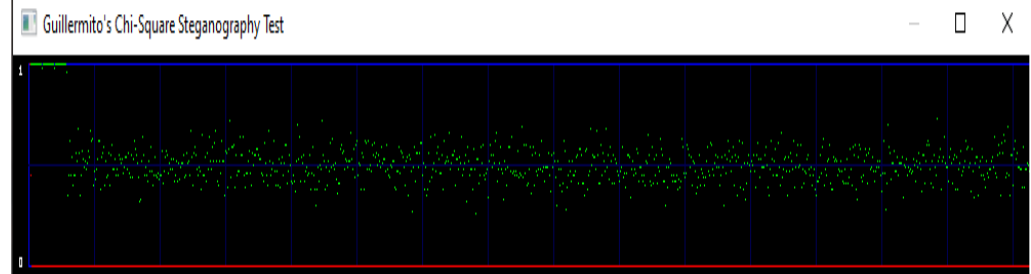
Figure 11. Chi-Square on Proposed Stego- Lena Image .